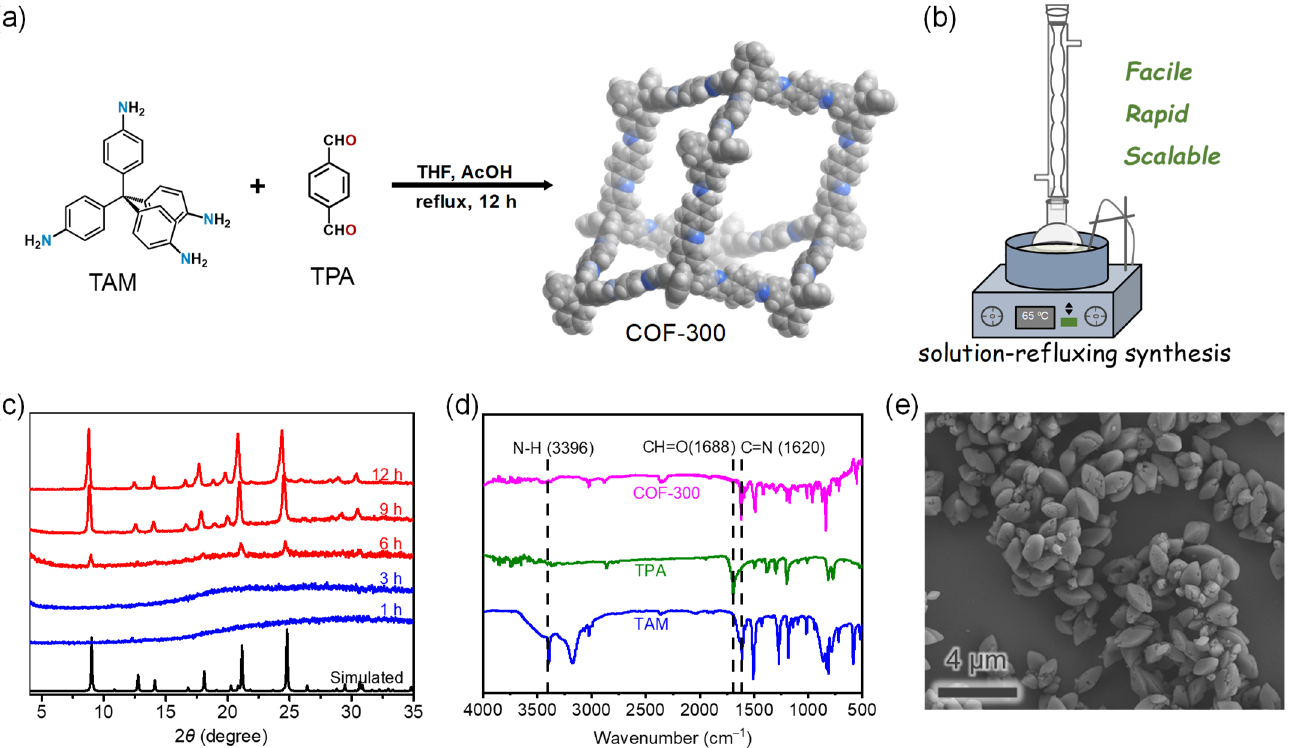
Figure 2. ( a ) Synthetic route of COF-300; ( b ) Schematic illustration of solution-refluxing synthesis method; ( c ) Reaction time-dependent PXRD patterns of products in solution-refluxing synthesis method; ( d ) The IR spectra of TAM, TPA and solution-refluxing synthesized COF-300; ( e ) The SEM photograph of solution-refluxing synthesized COF-300.